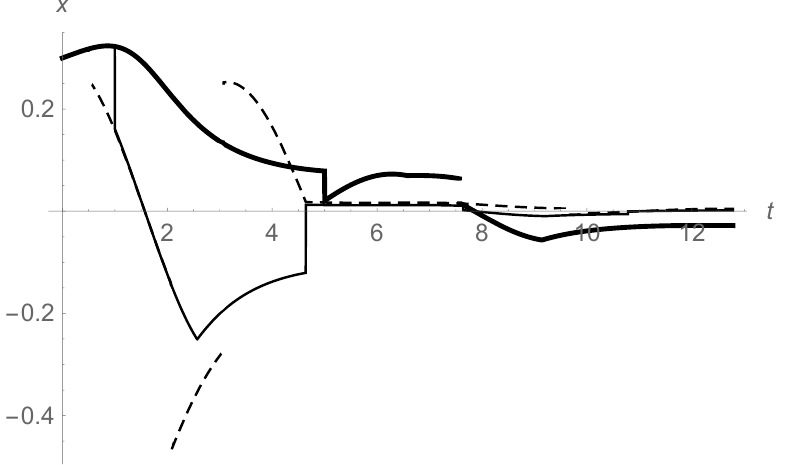
Figure 4: Graphs of solutions of (44) for various values of random variables τ k